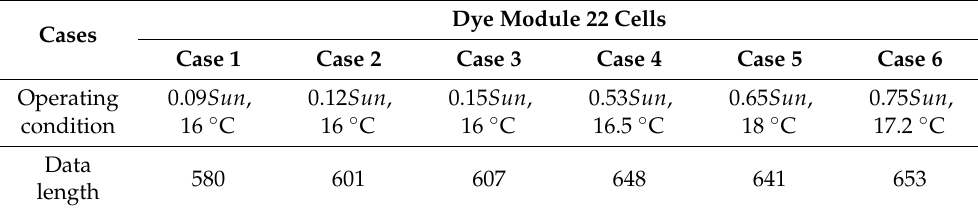
Table 2. The considered cases throughout the analysis.